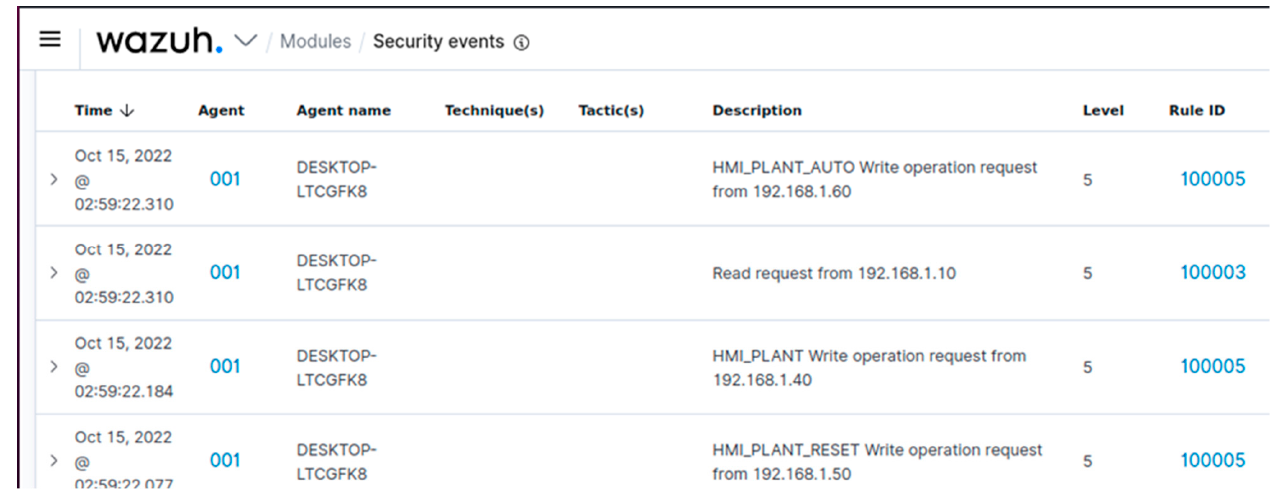
Figure 18 . SWaT Event Monitoring Rules. Figure 18. SWaT Event Monitoring